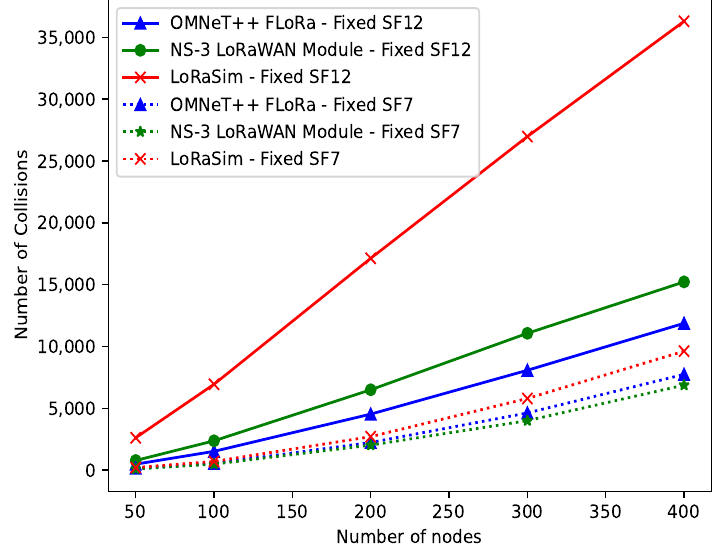
Figure 12. Number of collisions vs. number of